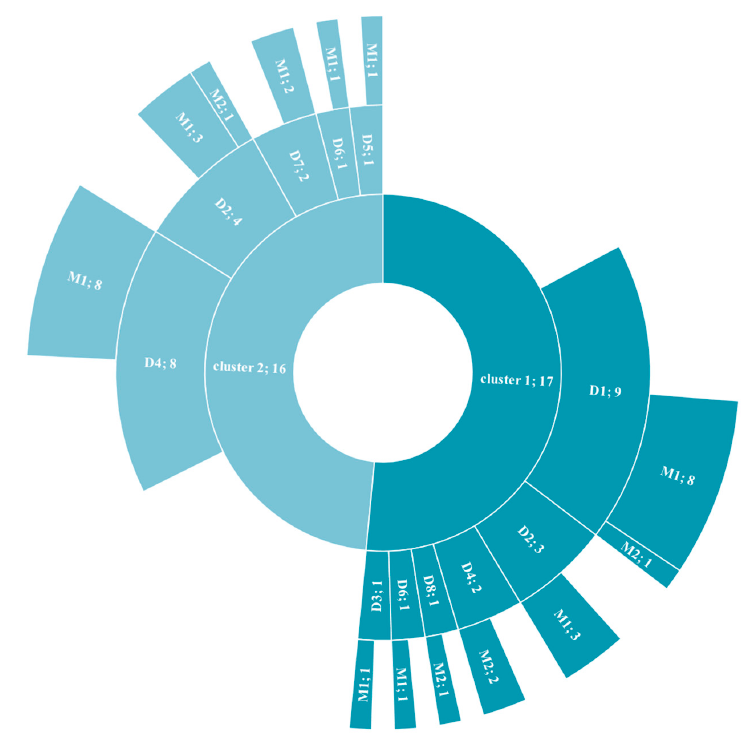
Figure 1. Distribution of diagnostic criteria across clusters.